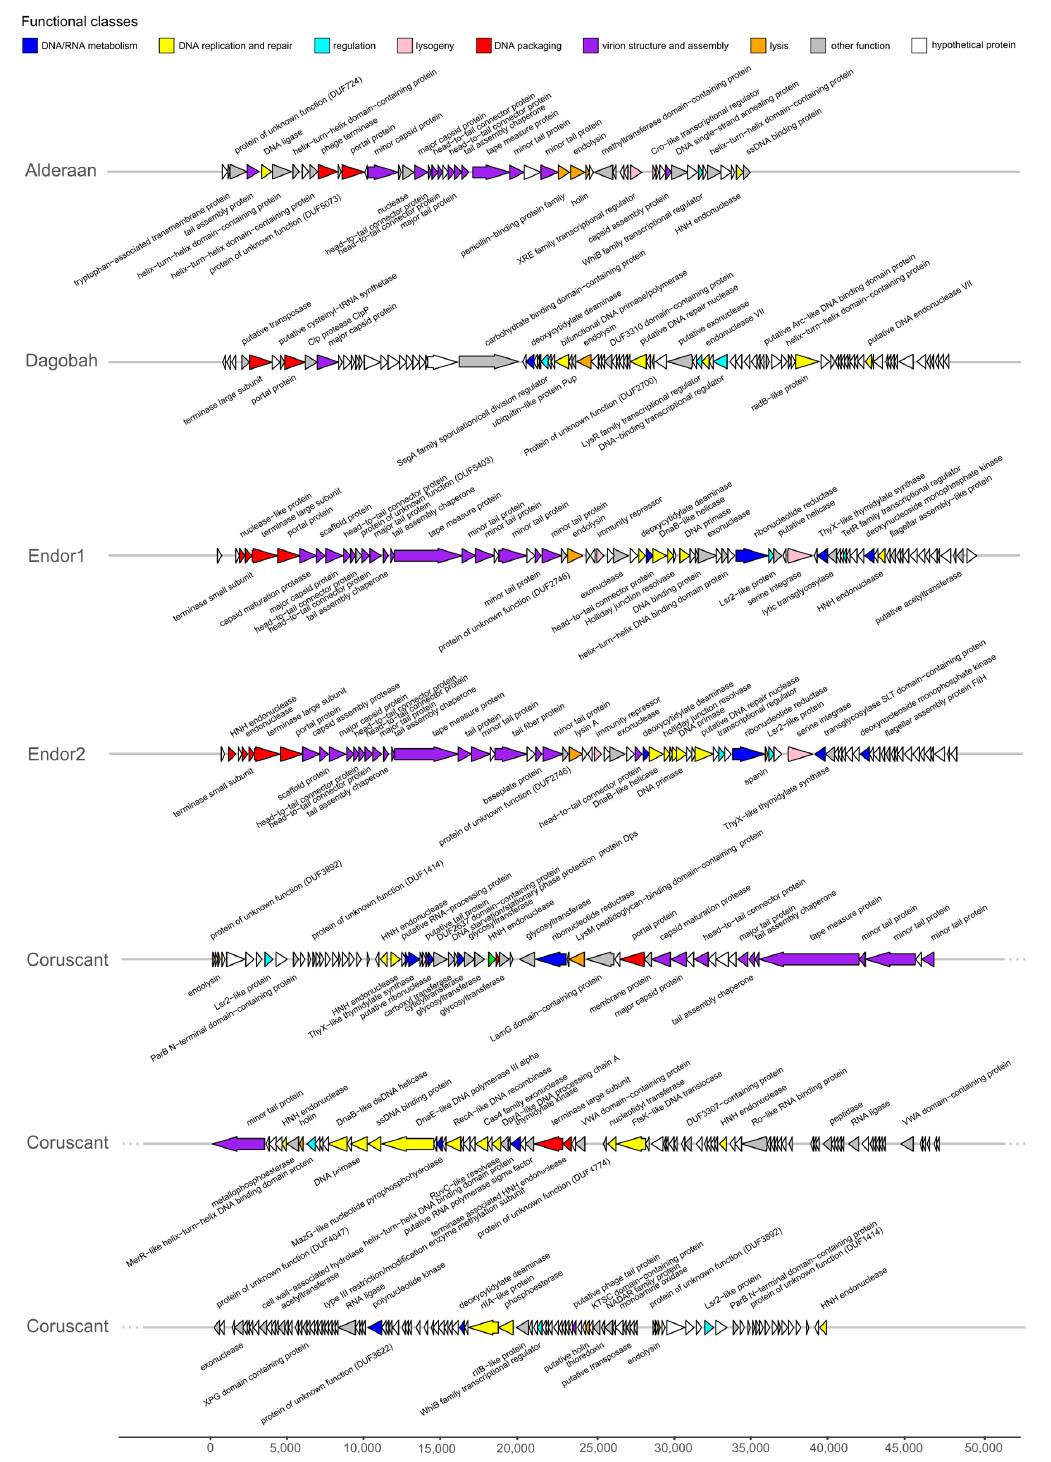
Figure3. Genomemapofthe five Streptomyces phages. Openreadingframes(ORFs)wereidentifiedwith Prodigal and functionally annotated using an automatic pipeline based on Prokka [25]. The functional annotation was automatically improved and curated using hidden Markov models (HMMs), and Blastp searches [26] against di ff erent databases (Prokaryotic Virus Orthologous Groups (pVOGs) [27], viral proteins and Conserved Domain Database (CDD) [28]. Genome maps were created using the R package